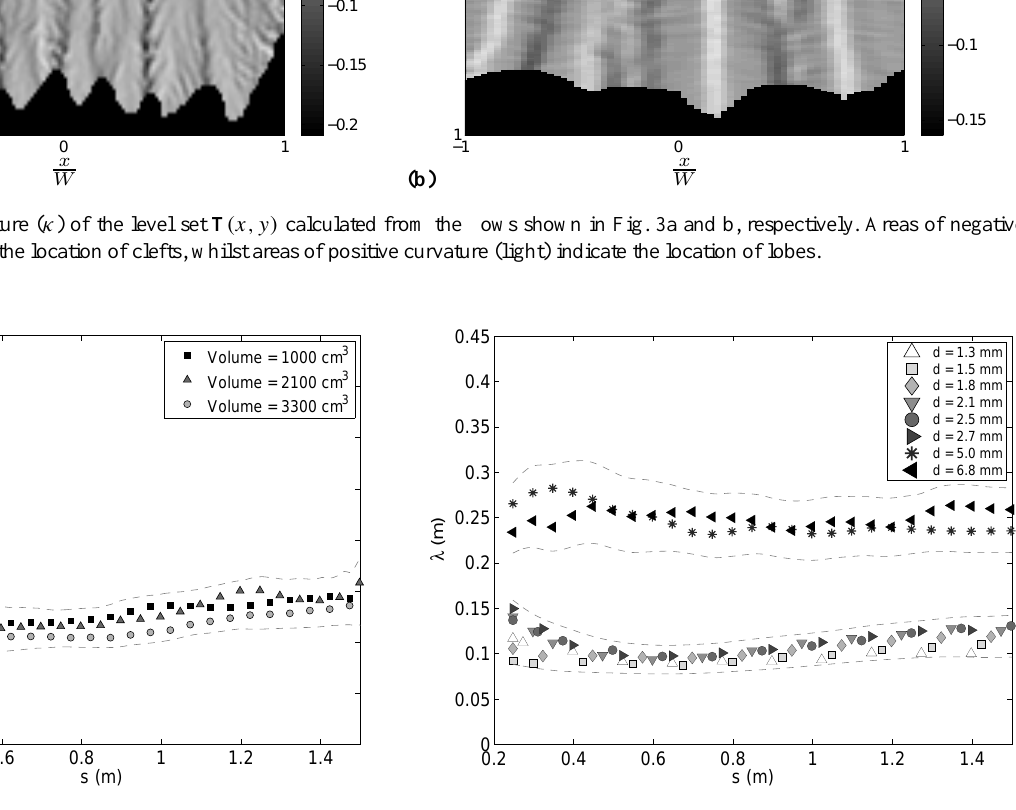
Fig. 8. Average wavelength ( λ ) versus distance from line release ( s ), plus or minus the standard deviation from the mean (dashed